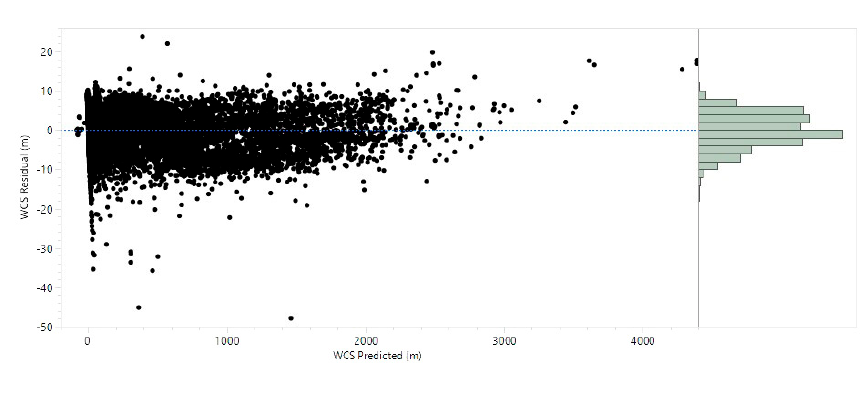
Table 18. Comparison of 3DEP data to various global datasets using OPUS checkpoints ( n = 24,707).